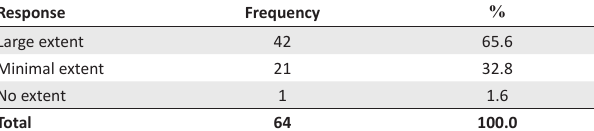
TABLE 4: Summary of respondents’ views on how exposure to learning through the blended learning mode contributed to the development of their online critical literacy skills.